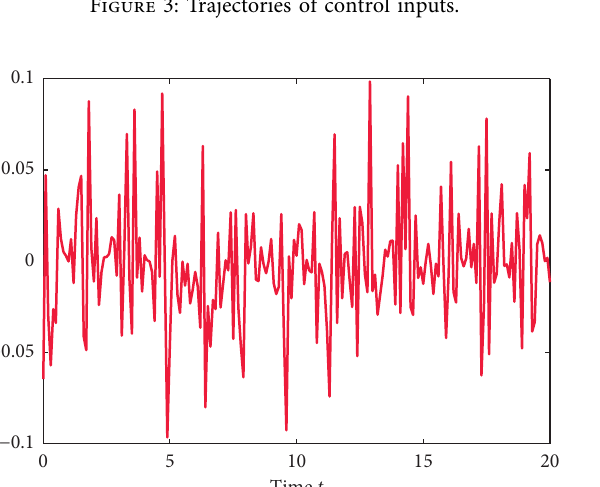
Figure 3: Trajectories of control